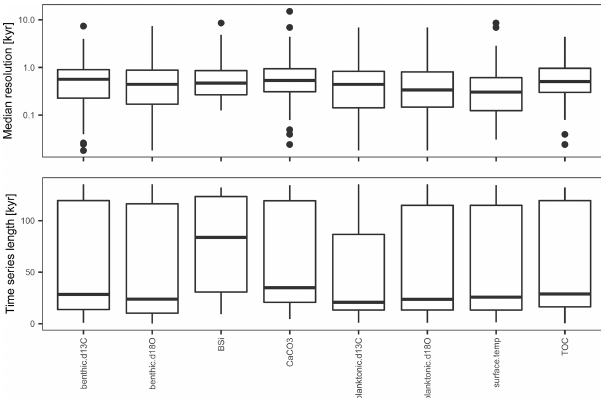
Figure 5. Median resolution of the time series in version 1.0.0 of the PalMod 130k marine palaeoclimate data synthesis. Box-and- whisker plots show the spread of resolution per parameter. For ben- thic foraminifera δ 13 C the resolution data are restricted to time se- ries containing data measured on shells of the genus Cibicidoides